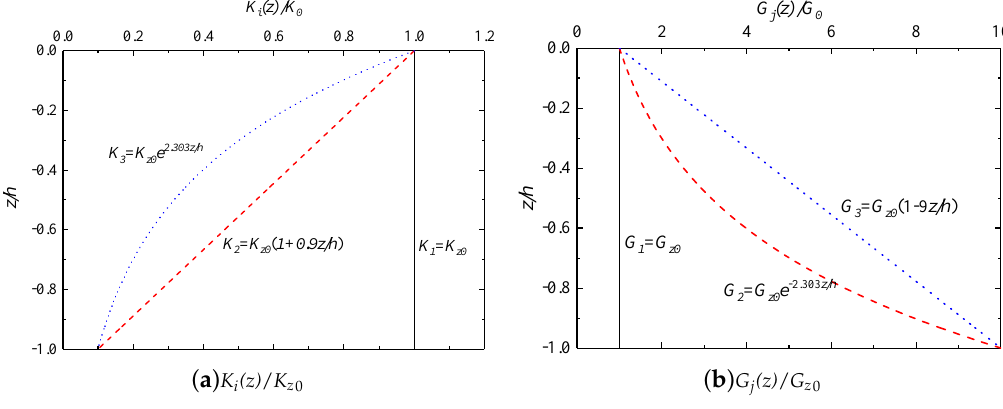
Figure 2. Three different cases of depth